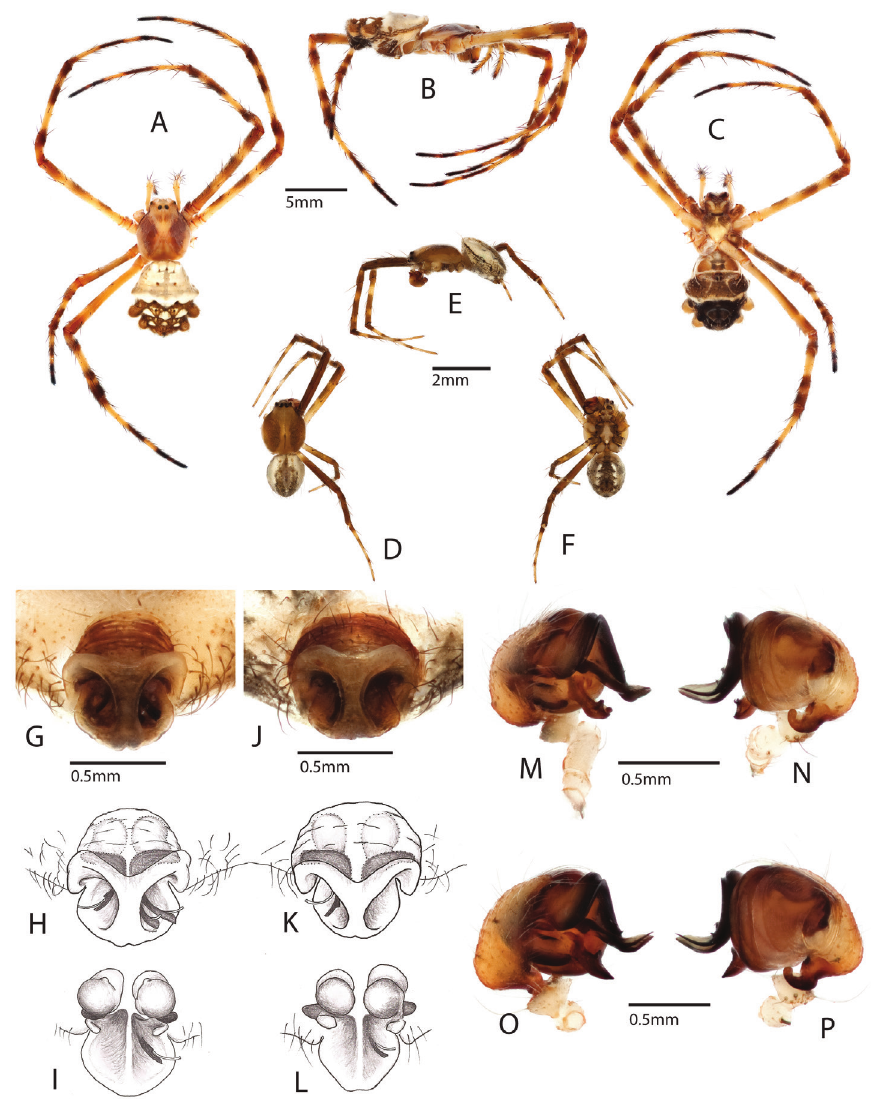
Figure 4. Female holotype Argiope butchko sp. n. a dorsal b lateral c ventral; Male paratype Argiope butchko sp. n. d dorsal e lateral f ventral g external epigynum h external epigynum illustration showing spermatheca and spiraling ducts i internal epigynum illustration dorsal m palp lateral n palp ventral; Ar- giope argentata j external epigynum k external epigynum illustration showing spermatheca and spiraling ducts l internal epigynum illustration dorsal o palp lateral p palp ventral. A. butchko : A (127), C (133), C (157) C (178), T (190), G (208), C (226), A (293), G (316), A (379, G (502), G (508), C (607); A. argentata : G (49), G (211), A (508), A (511), G